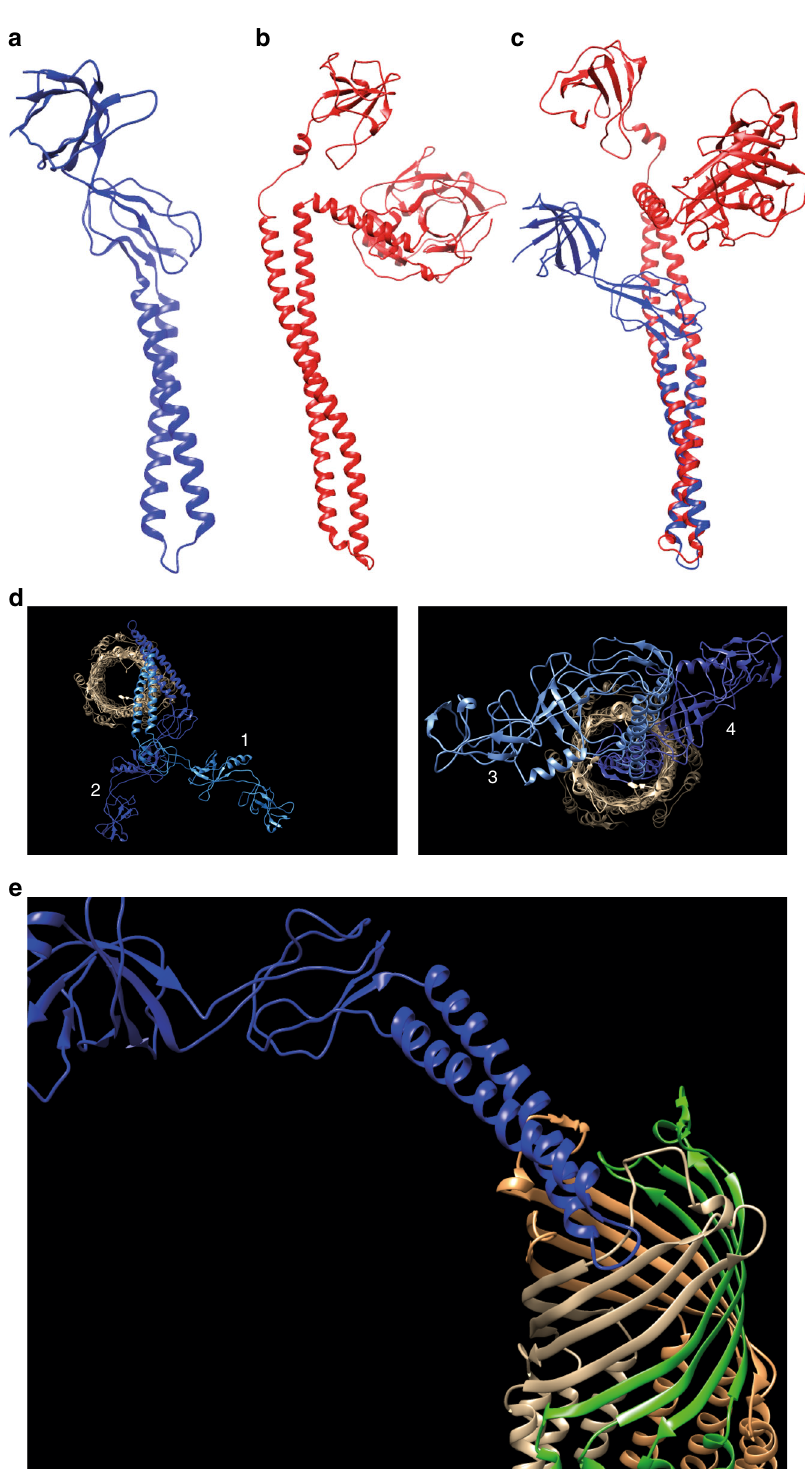
Fig. 7 AcrA structural analysis. a – c Structural superposition of AcrA and Colicin E3. a AcrA (PDB ID: 5NG5 [https://doi.org/10.2210/pdb5NG5/pdb]). b Colicin E3 (PDB ID: 2B5U [https://doi.org/10.2210/pdb2B5U/pdb]). c Superposition of a , b using Chimera matchmaker 93 . The RMSD value was 0.85 Å. d , e Model for AcrA-TolC binding. AcrA and TolC structures (PDB ID 5NG5) were used to predict possible modes of their interaction (see “ Methods ” ). d The best models are presented in decreasing order (1 – 4) of probability. AcrA, all shades of Blue; TolC, gray, brown, and green. e Sideview of the best model (#1). It is physically not very probable for a full-length AcrA (~49 Å diameter) to enter the cell through the TolC pump (~29 Å